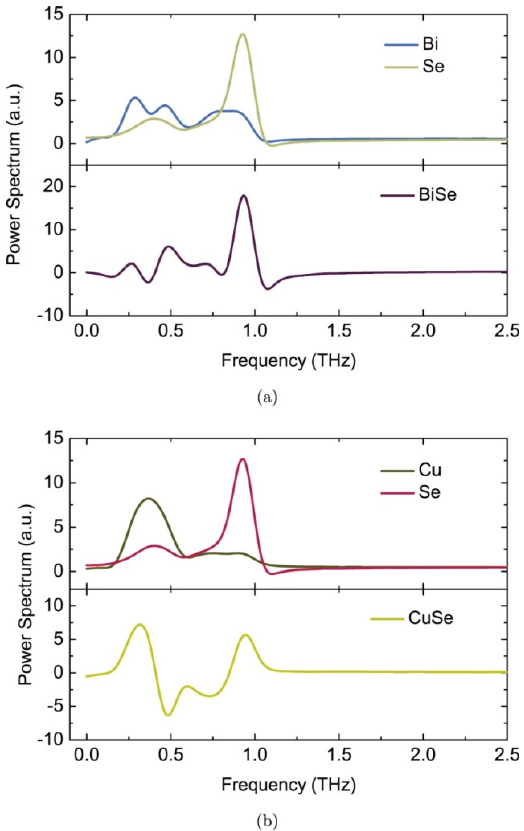
Figure 2. Power spectrum of the self-and cross-VAF. ( a ) Power spectrum of self- and cross-VAF of Bi and Se. Blue and beige lines represent Bi and Se self-VAF, respectively. The Bi/Se cross-VAF shows with purple line; ( b ) Power spectrum of self- and cross-VAF of Cu and Se. Brown and purple lines represent Cu and Se self-VAF, respectively. The Cu/Se cross-VAF is represented yellow line. Reproduced with permission from Reference [46]. Copyright 2015, IOP Publishing.